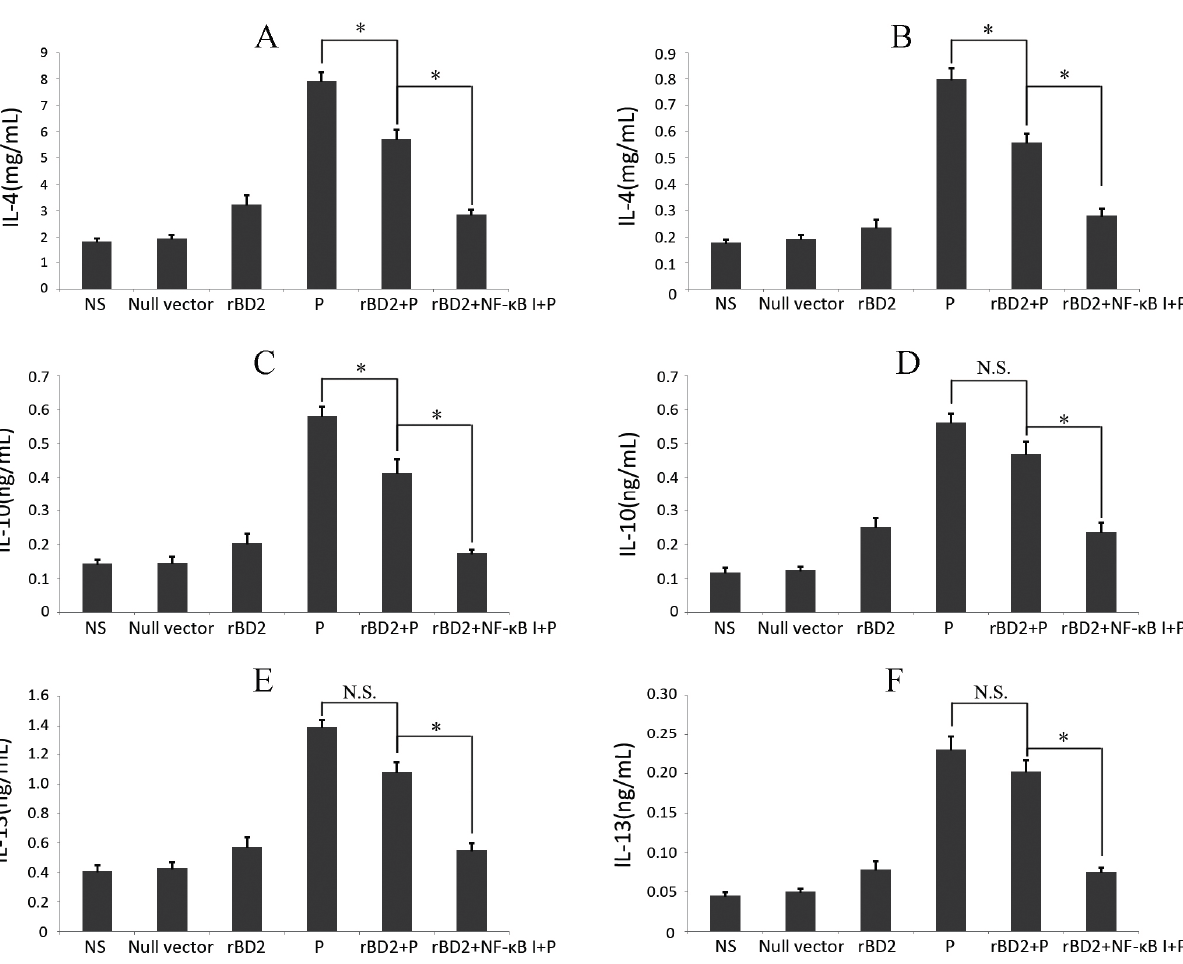
Figure 4. Effects of rBD2 on anti-inflammatory cytokines. Quantitative analysis of IL-4 ( A , B ); IL-10 ( C , D ) and IL-13 ( E , F ) in lung tissue homogenates ( A , C , E ) and peripheral blood samples ( B , D , F ) in each group. Data were expressed as mean ± SD ( n = 6). Groups: normal saline group (NS), group treated with null lentivirus (null vector), Pseudomonas aeruginosa infected group (P), group treated with rBD2 expression lentivirus ( rBD2 ), Pseudomonas aeruginosa infected group pretreated with rBD2 expression lentivirus ( rBD2 + P), group pretreated with rBD2 expression lentivirus and the inhibitor of NF- κ B ( rBD2 + NF- κ B I). * p < 0.05, and N.S. no significant